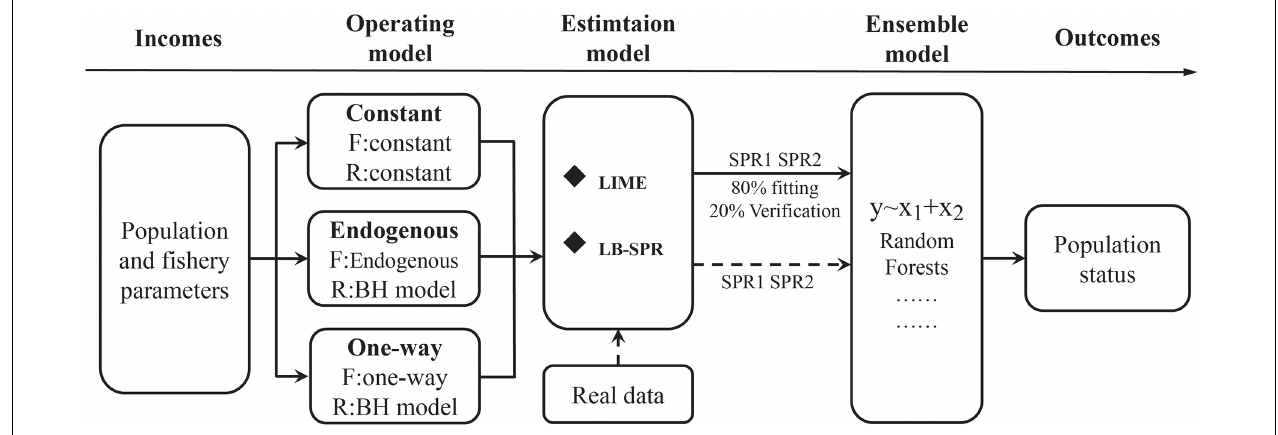
FIGURE 2 | Flow chart diagram of the simulation process and case